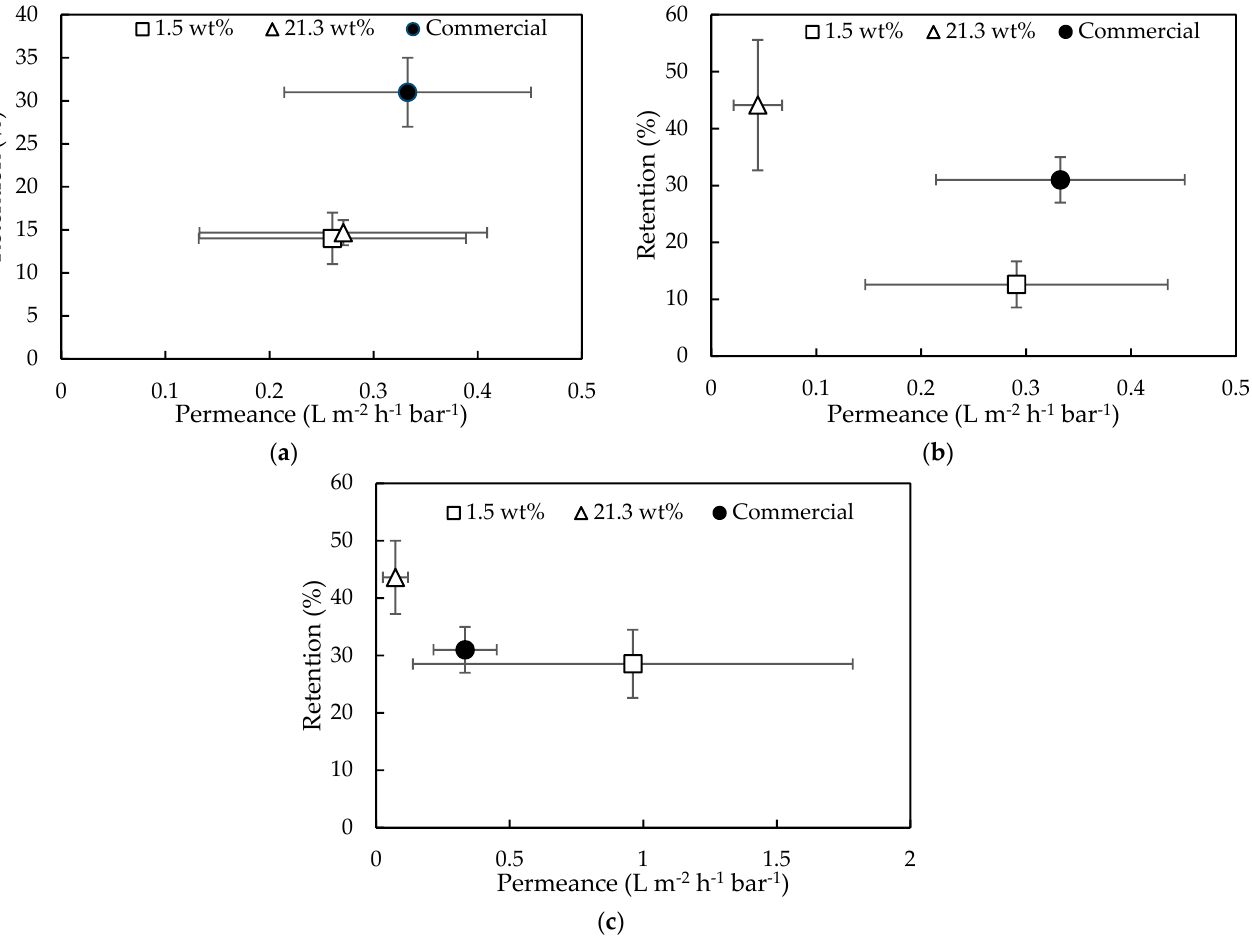
Figure 7. Water/ EtOH permeance and EA retention of GEA RO membrane (type AF) and membranes synthesized with IL containing 1.5 wt% and 21.3 wt% H 2 O, applying ( a ) 60 s, ( b ) 150 s, and ( c ) 300 s reaction time.